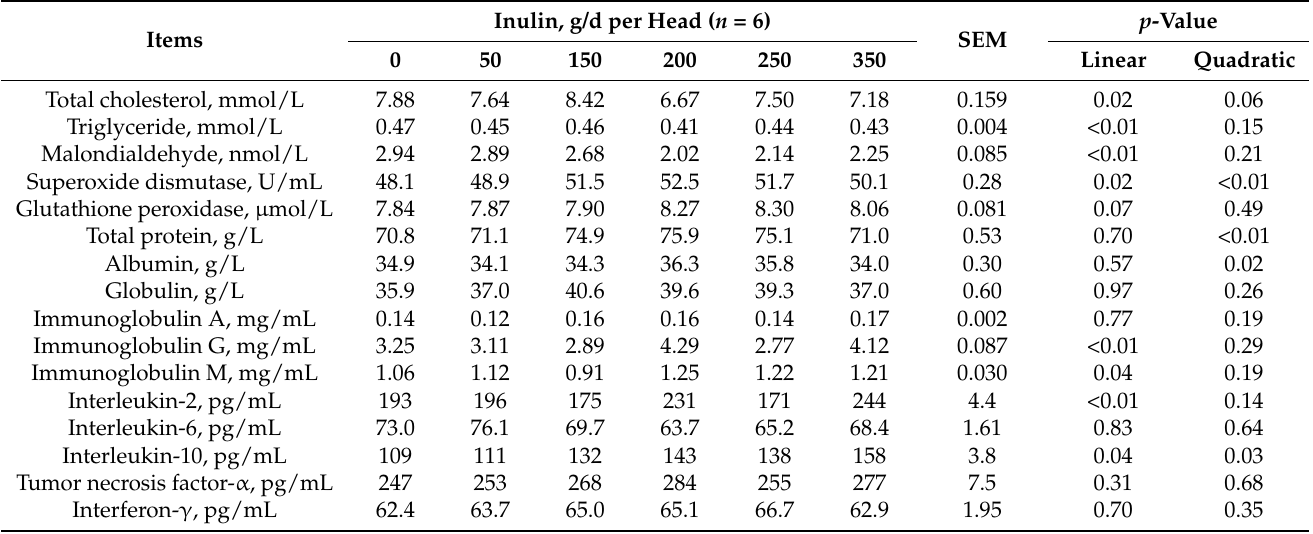
Table 5. Effects of inulin on serum metabolites in dairy